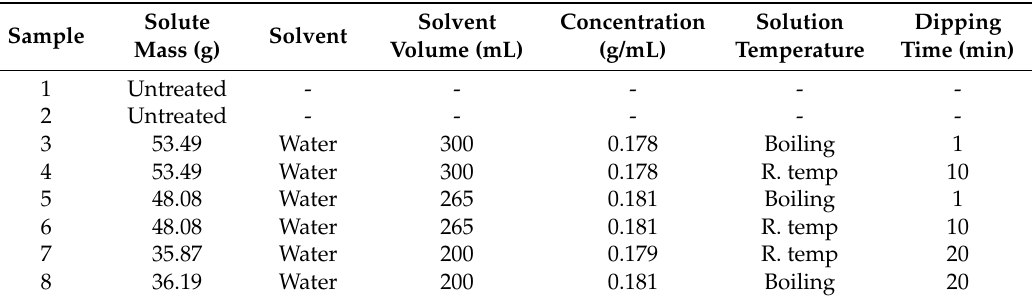
Table 3. Impregnation conditions of the